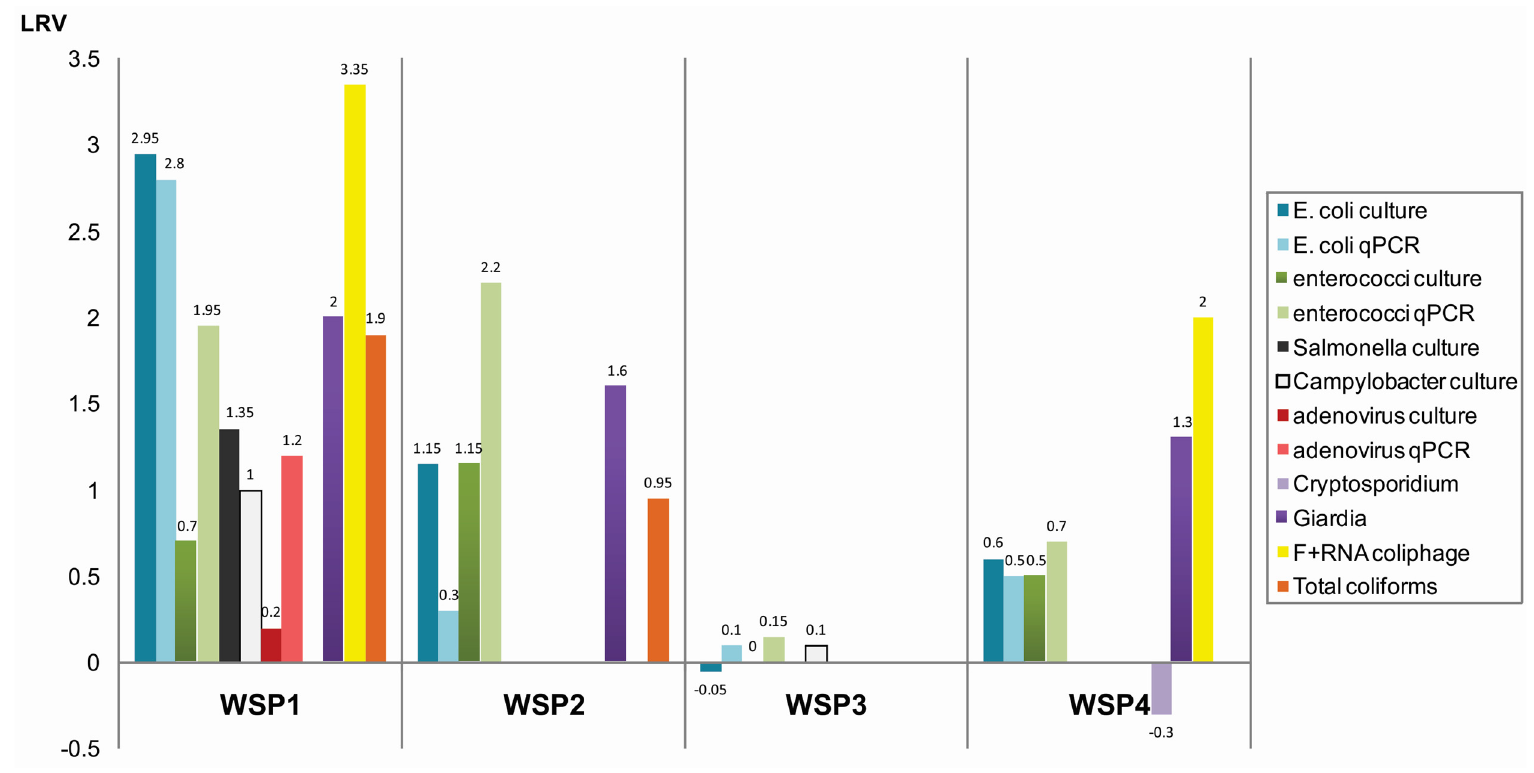
Figure 2. Average removal of microorganisms in maturation ponds located at four WSPs and tested during two years. Graph summarizes log removal values (LRV) presented in Table 3. Data on qPCR for Salmonella enterica and Campylobacter jejuni are not shown due to lack of detection of these pathogens in the maturation ponds. Removal of Cryptosporidium parvum are not shown due to absence of oocysts in effluent of WSP1. Samples taken from WSP2, WSP3 and WSP4 were tested only partially, blanks are for microorganisms which were not tested.